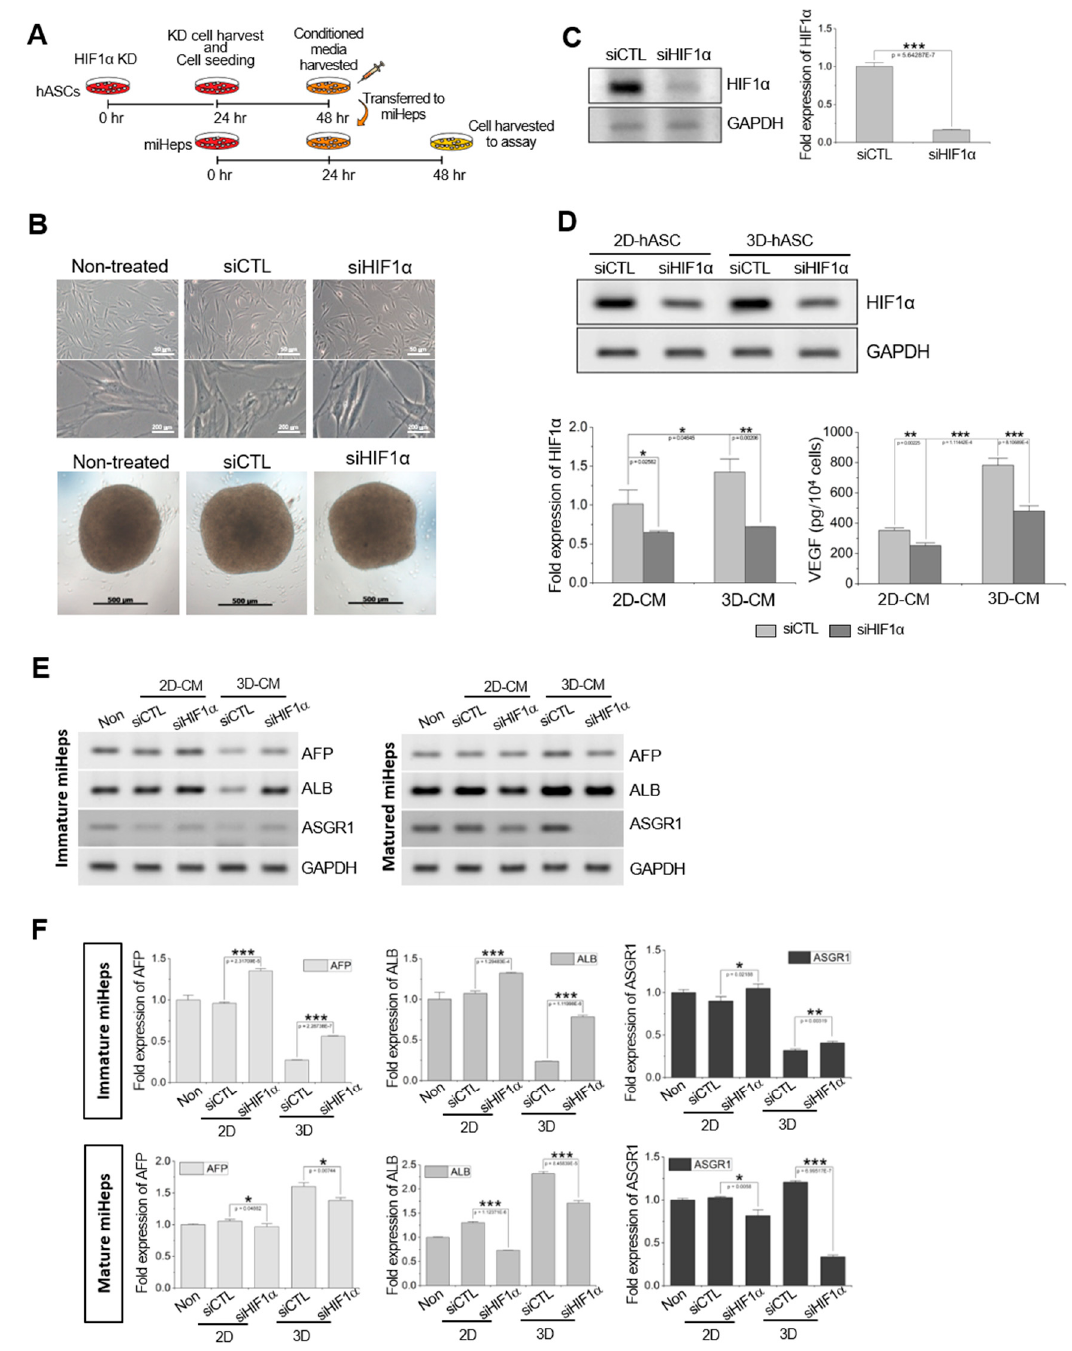
Figure 6. E ff ects of HIF1 α on miHep hepatic function. ( A ) Schematic diagram of the experimental procedure. KD indicates knockdown. ( B ) Cell morphology of hASCs transfected with siRNA; siCTL, control siRNA; siHIF1 α , HIF1 α siRNA. Reverse-transcription PCR analysis of ( C ) HIF1 α knock-down in hASCs 24 h after transfection and ( D ) 2D- and 3D-cultured hASCs 24 h after additional culture. Data represent the mean ± SD, * p < 0.05; ** p < 0.005; *** p < 0.0005. ( E ) Reverse-transcription PCR and ( F ) real-time PCR analysis of hepatic genes in miHeps treated with the CM of HIF1 α -transfected 2D- or 3D-cultured hASCs. Data represent the mean ± SD, * p < 0.05; ** p < 0.005; *** p <